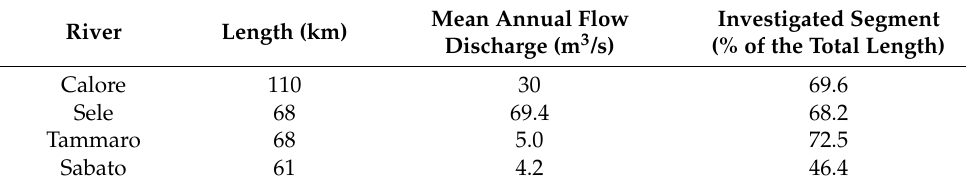
Table 2. Main features of the investigated river